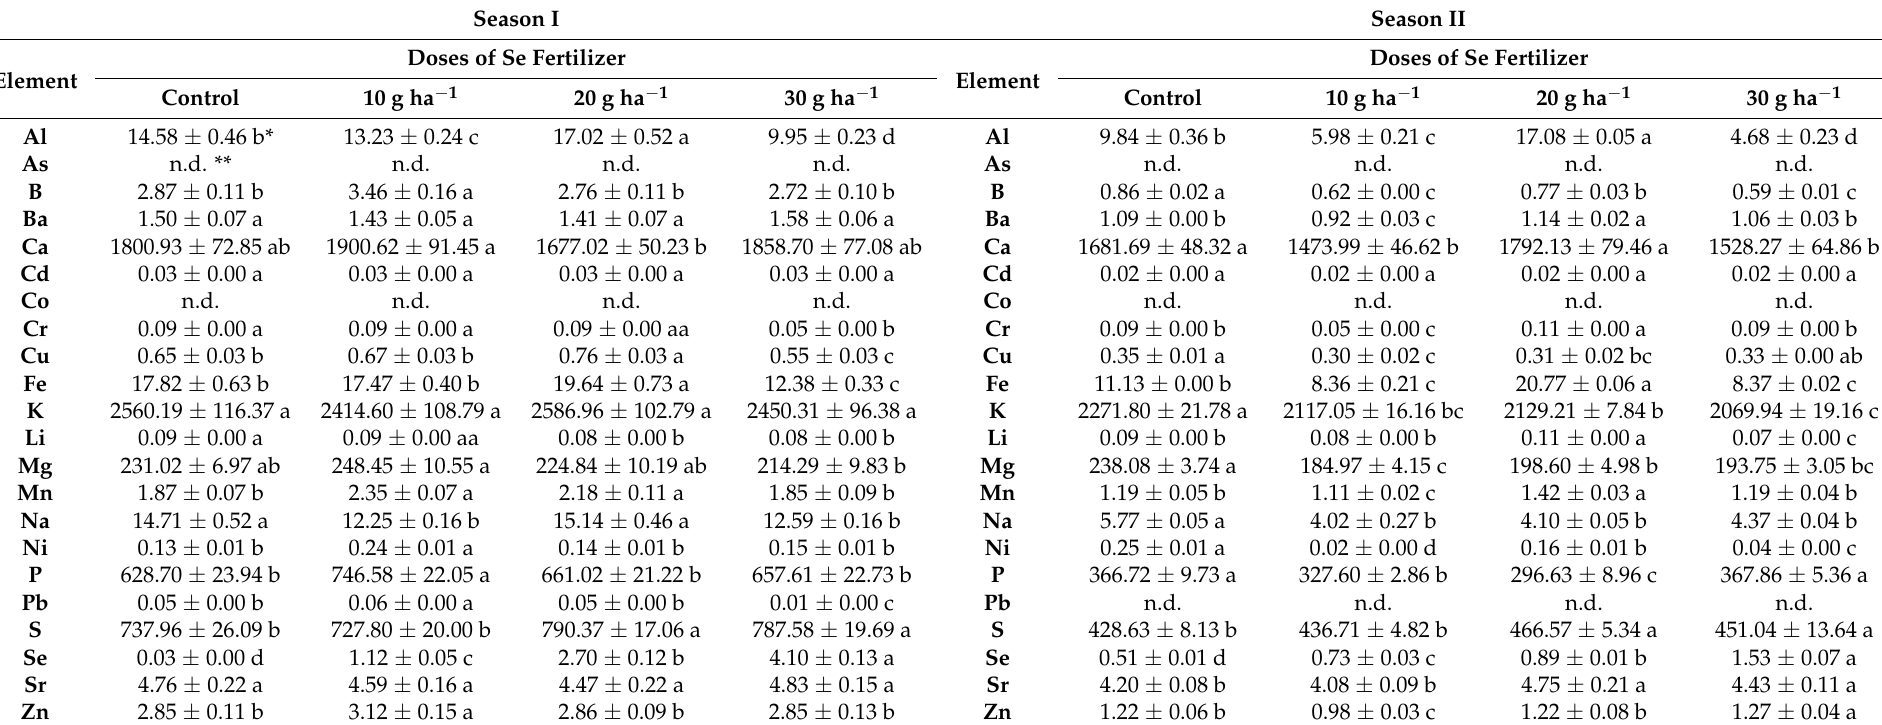
Table 4. The contents ( µ g g − 1 of fresh weight ± SD) of biogenic elements observed in the leaves of A. schoenoprasum for both